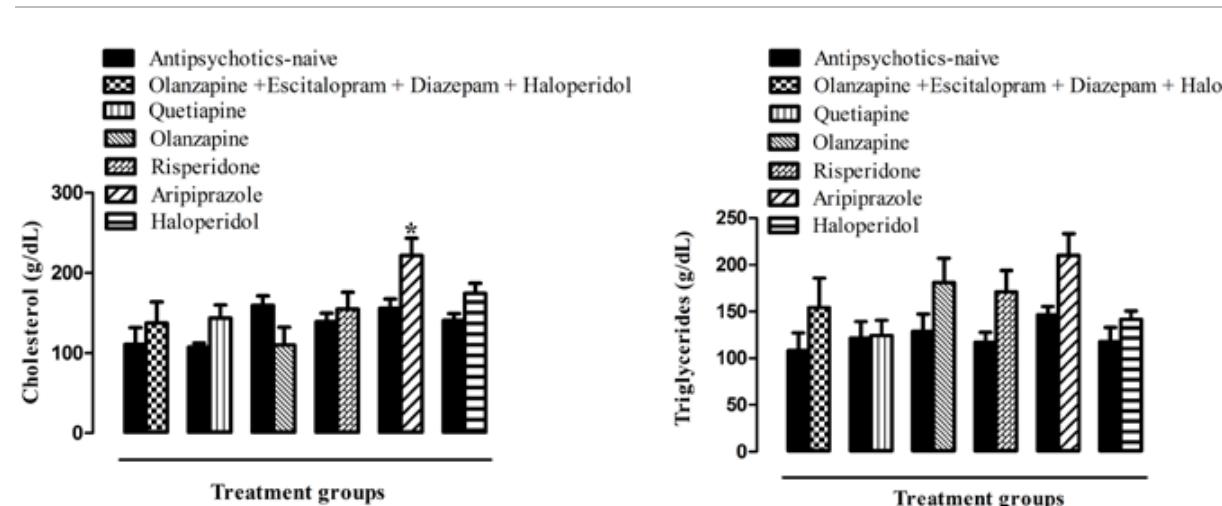
FIGURE 7 - Effect of selected antipsychotics on cholesterol: Antipsychotic-naïve patients were treated with olanzapine in combination with escitalopram, diazepam (STAT, I.V)